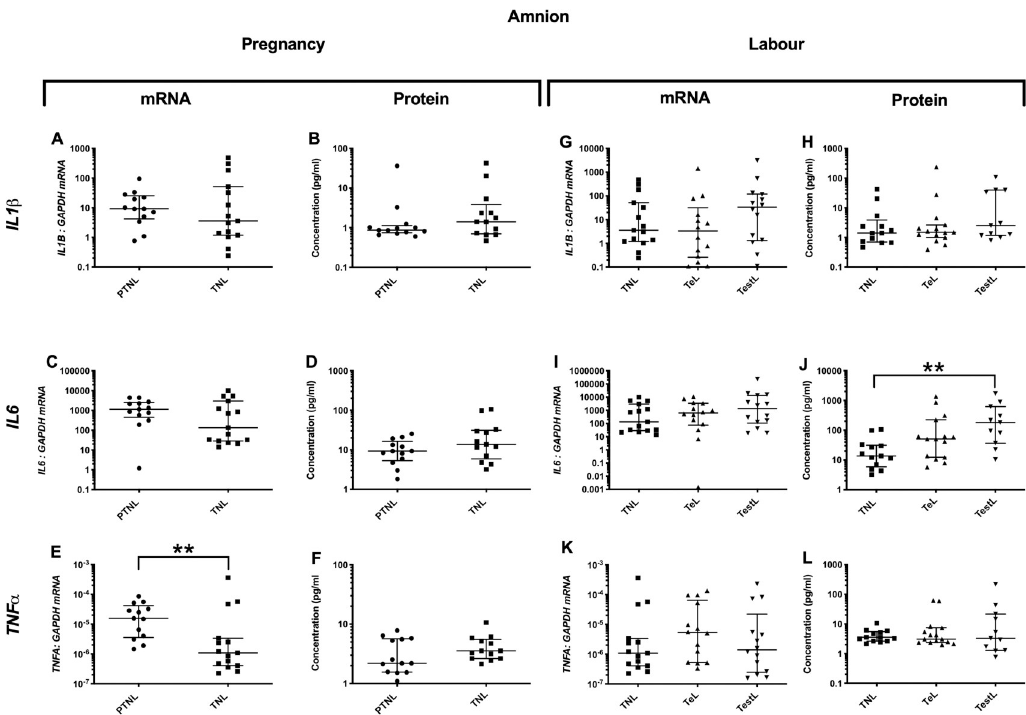
Fig 1. Pro-inflammatory cytokine changes in the amnion. Amnion tissue levels of cytokines from four groups of women (mean gestational age ± SD in each case), PTNL (33.8 ± 1.7 weeks, n = 12), TNL (39.3 ± 0.9 weeks, n = 13), TeL (cervical dilatation < 3cm, 38.6 ± 1.2 weeks, n = 15) and TestL (cervical dilatation > 3cm, 39.6 ± 1.2, n = 11) were compared. Tissue levels of the cytokines were quantified using Bio-plex human cytokine 19-plex-array kit (Bio-Rad) and a separate assay for CCL5 as describe in Materials and Methods . A subset of amnion samples, PTNL (33.3 ± 1.9 weeks, n = 13), TNL (39.0 ± 1.0 weeks, n = 15), TeL 38.5 ± 1.3 weeks, n = 14) and TestL (39.4 ± 1.1, n = 14) were used to compare the mRNA expression using rtPCR of the IL-1 β , IL6 and TNF α . Normally distributed data were analysed using a Student’s t-test for two groups and an ANOVA followed by a Dunnett’s or Bonferroni’s post-hoc test for three groups or more. Data that were not normally distributed were analysed using a Mann Whitney test for 2 groups and when comparing three groups or more a Friedman’s test, with a Dunn’s multiple comparisons post-hoc test. The data are shown as median with interquartile range. The p values are demonstrated by � is p < 0.05 and �� is p <